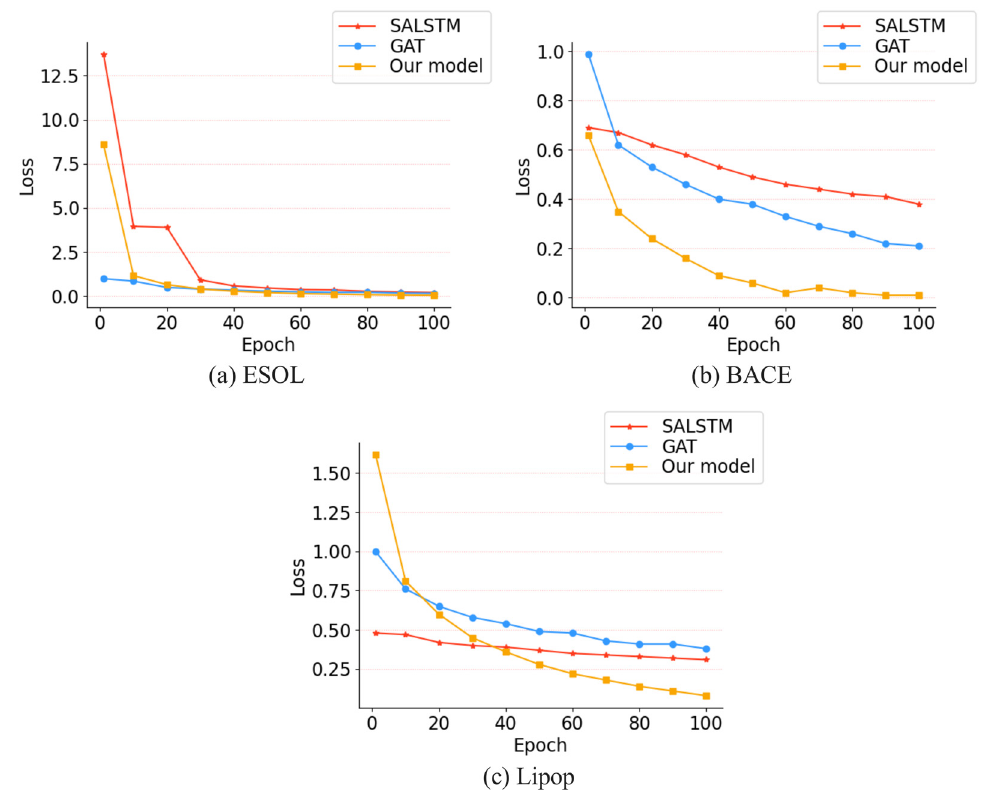
Figure 6. Training loss. ( a ) Training losses of different models for the ESOL dataset. ( b ) Training losses of different models for the BACE dataset. ( c ) Training losses of different models for the Lipop dataset.